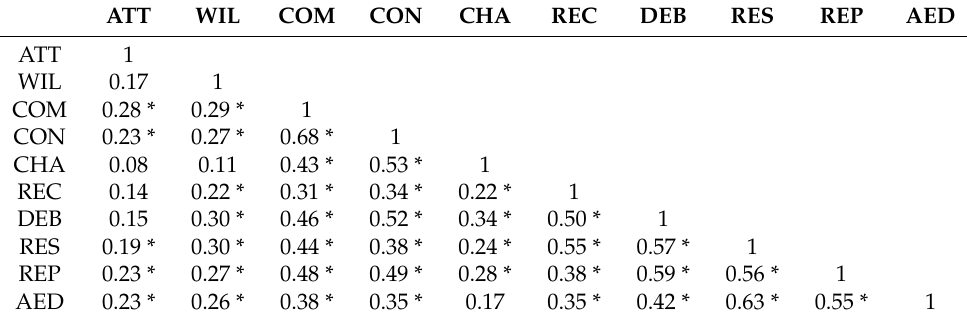
Table 5. The results indicated that Attitude in FAA was positively correlated with three SEFA dimensions: Responding and rescuing, Report and Safe use of an AED (r = 0.22~0.30, p < 0.001), whereas Willingness in FAA was positively correlated with all dimensions of SEFA (r = 0.22~0.30, p < 0.001). Table 5. The correlations among the dimensions of the FAA, WRH, and SEFA. ATT WIL COM CON CHA REC DEB RES REP AED ATT 1 0.17 1